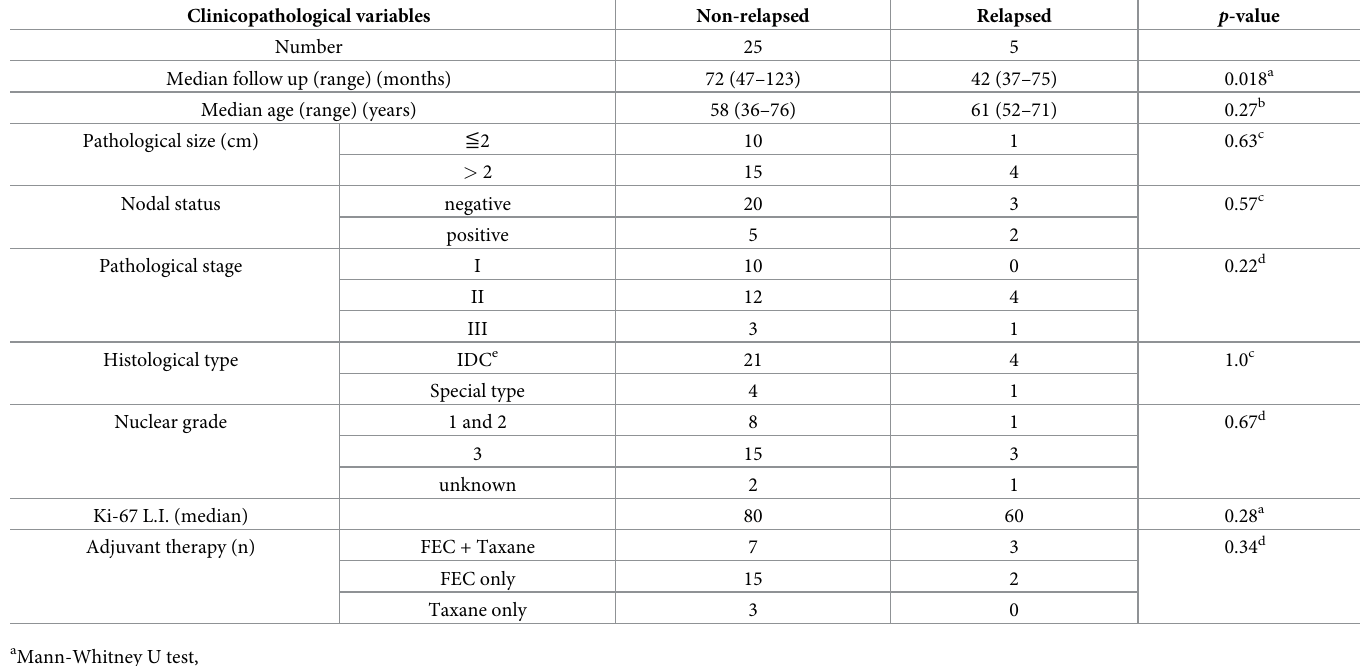
Table 1. Patient characteristics and treatment